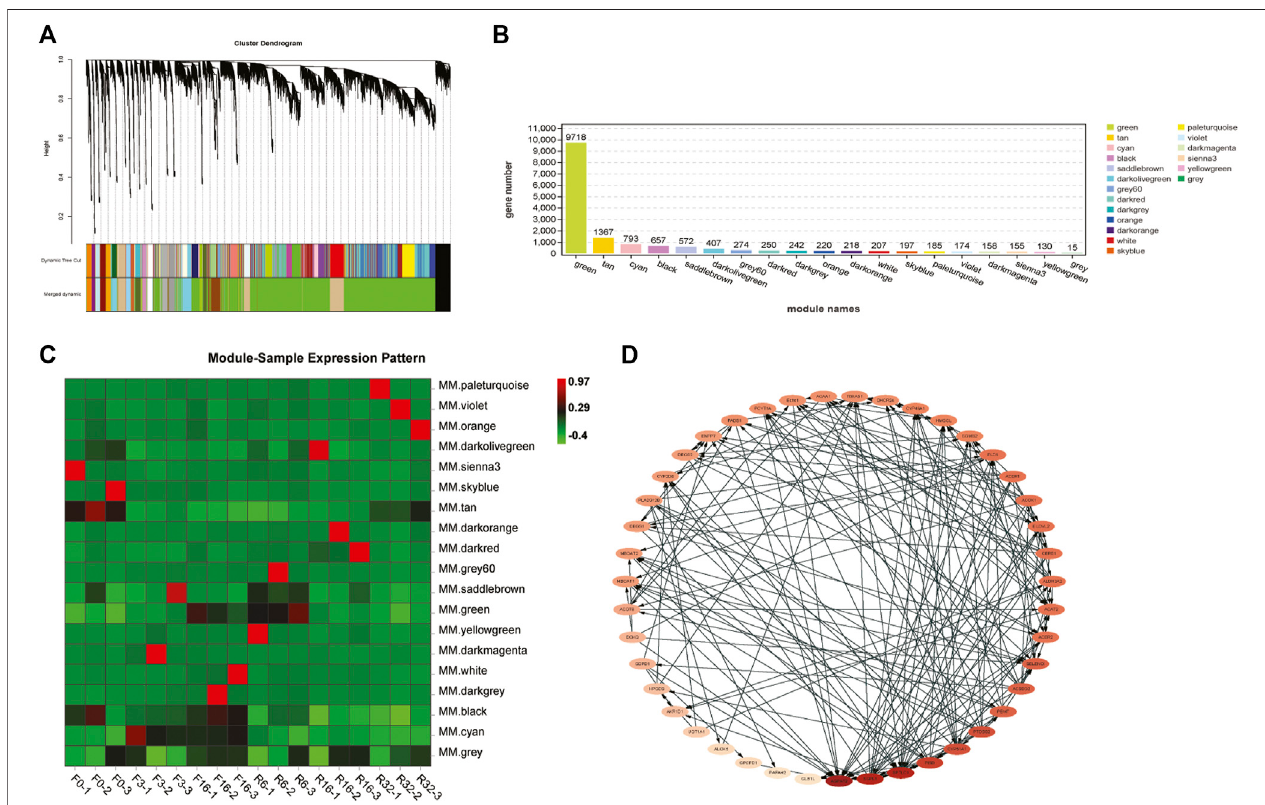
FIGURE 3 | WGCNA of genes in the liver. (A) Hierarchical cluster tree showing coexpression modules identi fi ed by WGCNA. Each leaf in the tree represents one gene. The major tree branches constitute 19 modules labeled with different colors. (B) Number of genes contained in each module. (C) Expression patterns of module genes in each sample are displayed by module eigenvalues. The value of module eigenvalues in each sample re fl ects the comprehensive expression level of all genes in each sample. (D) In selected modules, genes related to lipid metabolism interact with each other in the co-expression network, and the darker the color, the stronger the